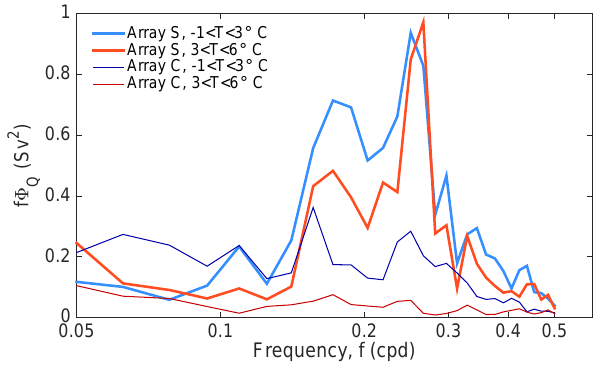
Figure 10. Variance-preserving spectra of volume transport for the upper and lower layers at mooring arrays C and S, respectively.